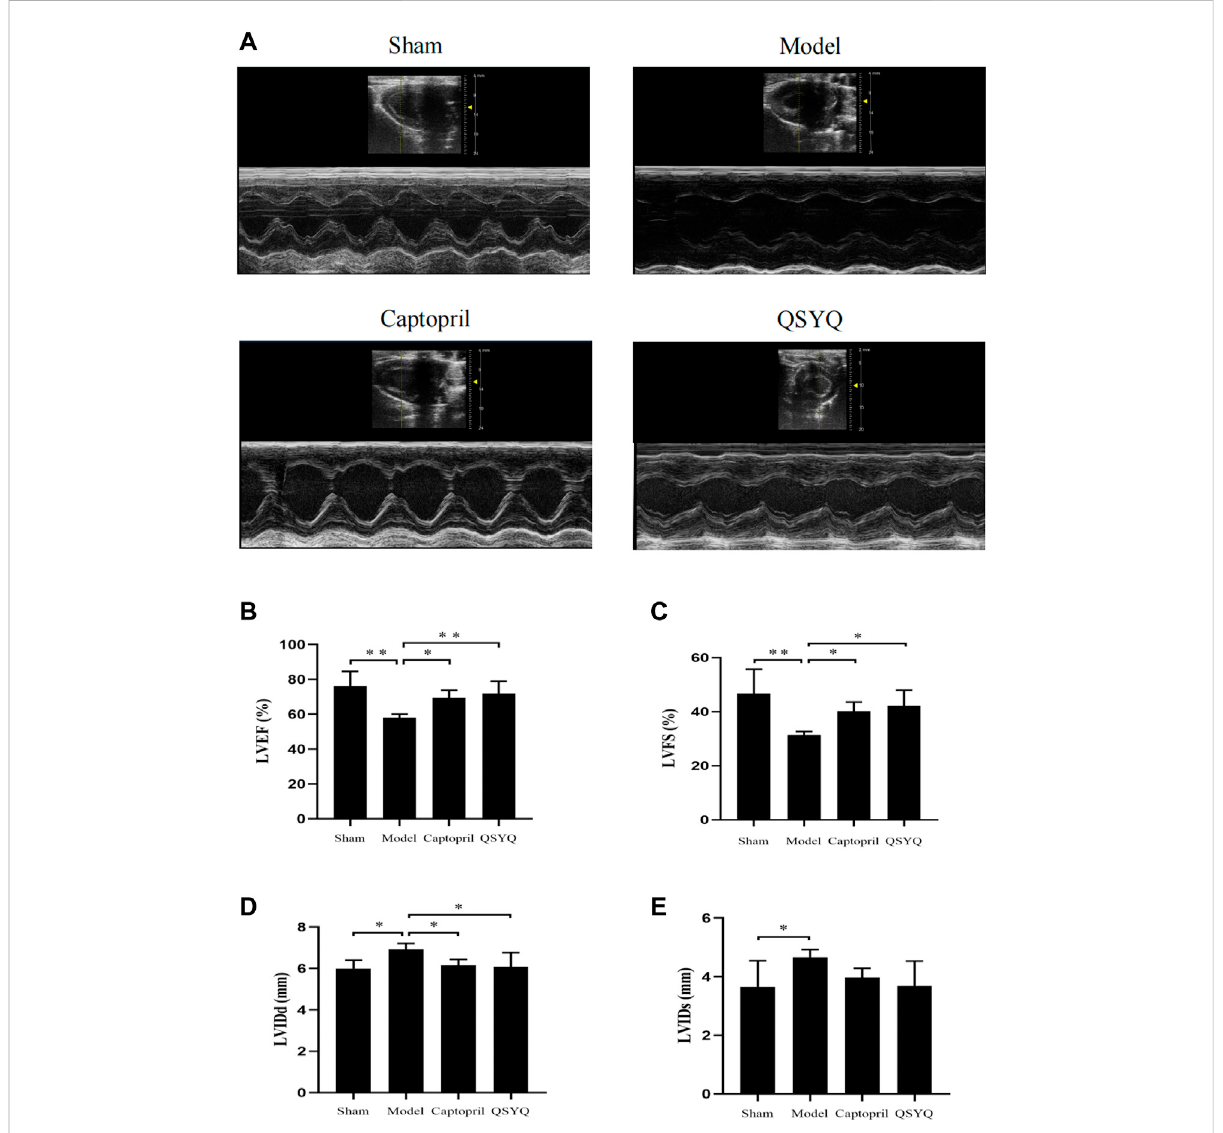
FIGURE 6 Effect of QSYQ on cardiac functional parameters. (A) : Representative M-mode images by echocardiography; (B) : Left ventricular ejection fraction, LVEF (%); (C) : Left ventricular fraction shortening, LVFS (%); (D) : Left ventricular end diastolic diameter, LVIDd (mm); (E) : Left ventricular end systolic diameter, LVIDs (mm), n = 4 per group. Data are expressed as mean ± SD. * p < 0.05, ** p <